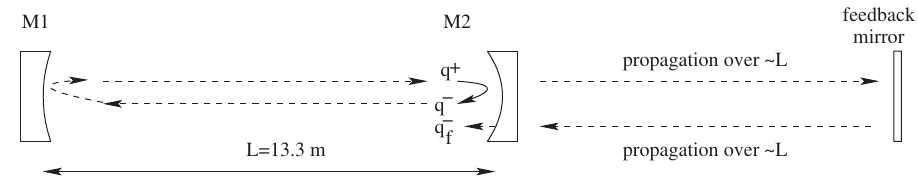
FIG. 6. Illustration of the definitions of the complex curvature radii involved in the feedback coefficient calculations. All radii are calculated at the same location: the location of the output coupler M 2 , inside the cavity, and leftwards. q (cid:1) correspond to the lasing mode. The feedback beam eventually reinjected and has a complex curvature radius q (cid:1) f